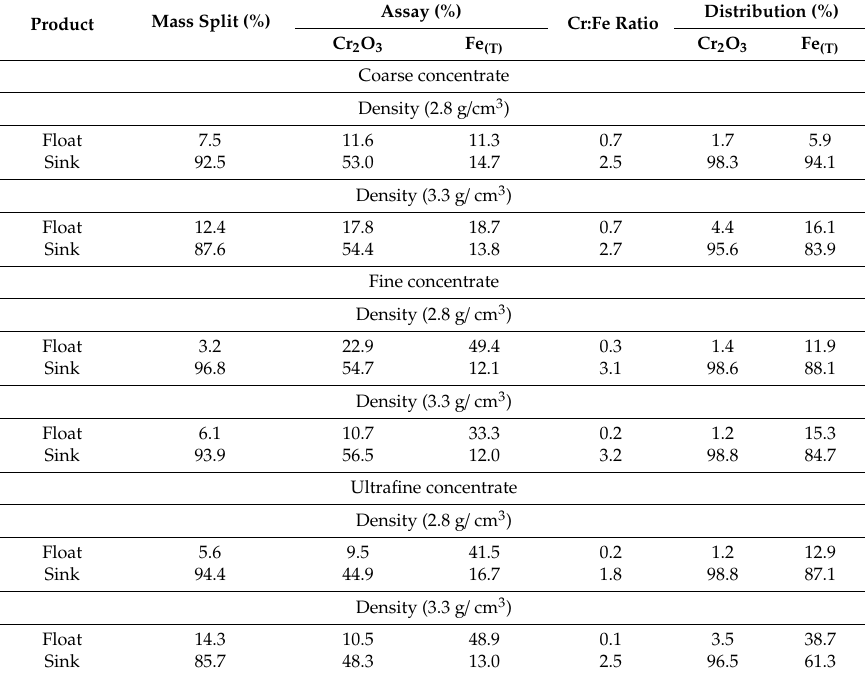
Table 4. Results of the heavy liquid separation for chromite